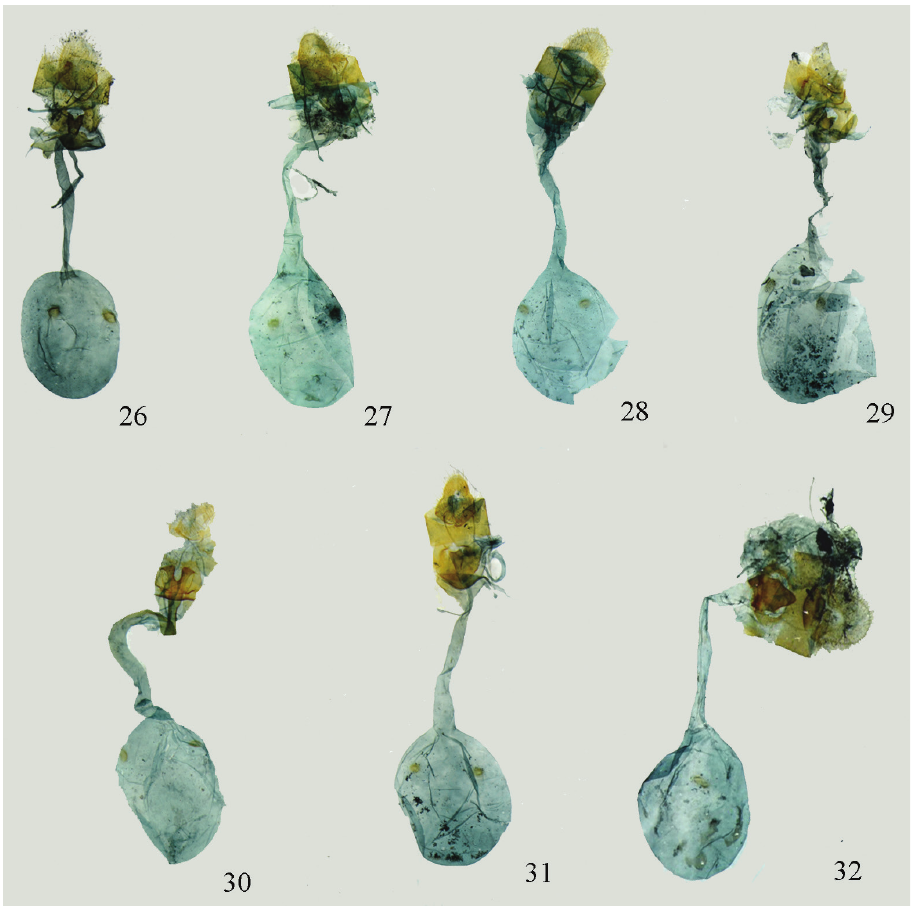
Figures 23–32. Female genitalia. 23 Lista angustusa sp. n., paratype, gen. slide no. Ep562 24 L. ficki (Christoph , 1881), gen. slide no. Ep552 25 L. gilvasa sp. n., paratype, gen. slide no. Ep563 26 L. haral- dusalis (Walker, 1859), gen. slide no. Ep557 27 L. insulsalis (Lederer, 1863), gen. slide no. Ep512 28 L. longifundamena sp. n., paratype, gen. slide no. Ep555 29 L. menghaiensis sp. n., paratype, gen. slide no. Ep558 30 L. plinthochroa (West, 1931), gen. slide no. Ep553 31 L. sichuanensis sp. n., paratype, gen. slide no. Ep554 32 L. variegata (Moore, 1888), gen. slide no. Ep603.